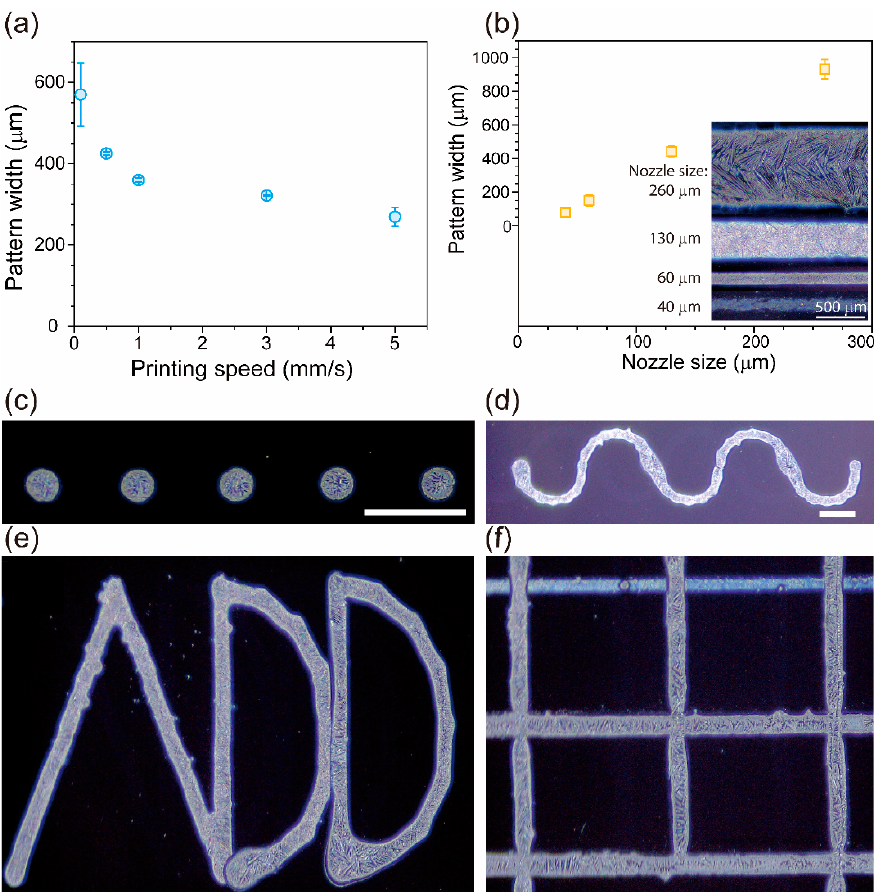
Figure 5. Widths of RDX patterns printed on the surfaces of UVO-treated Si wafers ( a ) at different speeds and ( b ) with different nozzle sizes (inner diameters). The inset of ( b ) shows representative RDX patterns printed by using various nozzle sizes from 40 μ m to 260 μ m. Various printed RDX patterns with different shapes were realized: ( c ) dot, ( d ) wavy, ( e ) alphabetic “ADD”, and ( f ) grid. They were printed on the UVO-treated surfaces of Si wafers. Scale bar = 500 μ m.